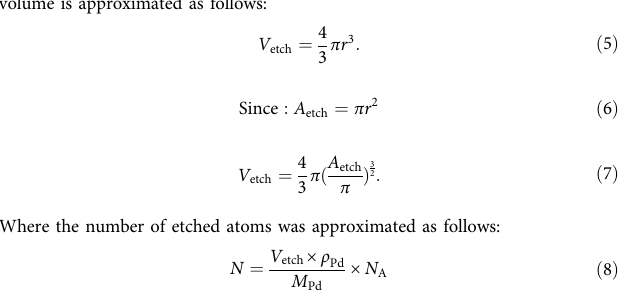
Fig. 10. Three directions were measured: upper-left to lower-right (UL – LR), upper- right to lower-left (UR – LL), and terrace defects direction, as shown in the cube with corner and terrace defects. Along each direction, only residual unetched Pd atoms are included. Distance was measured before a random direction was etched